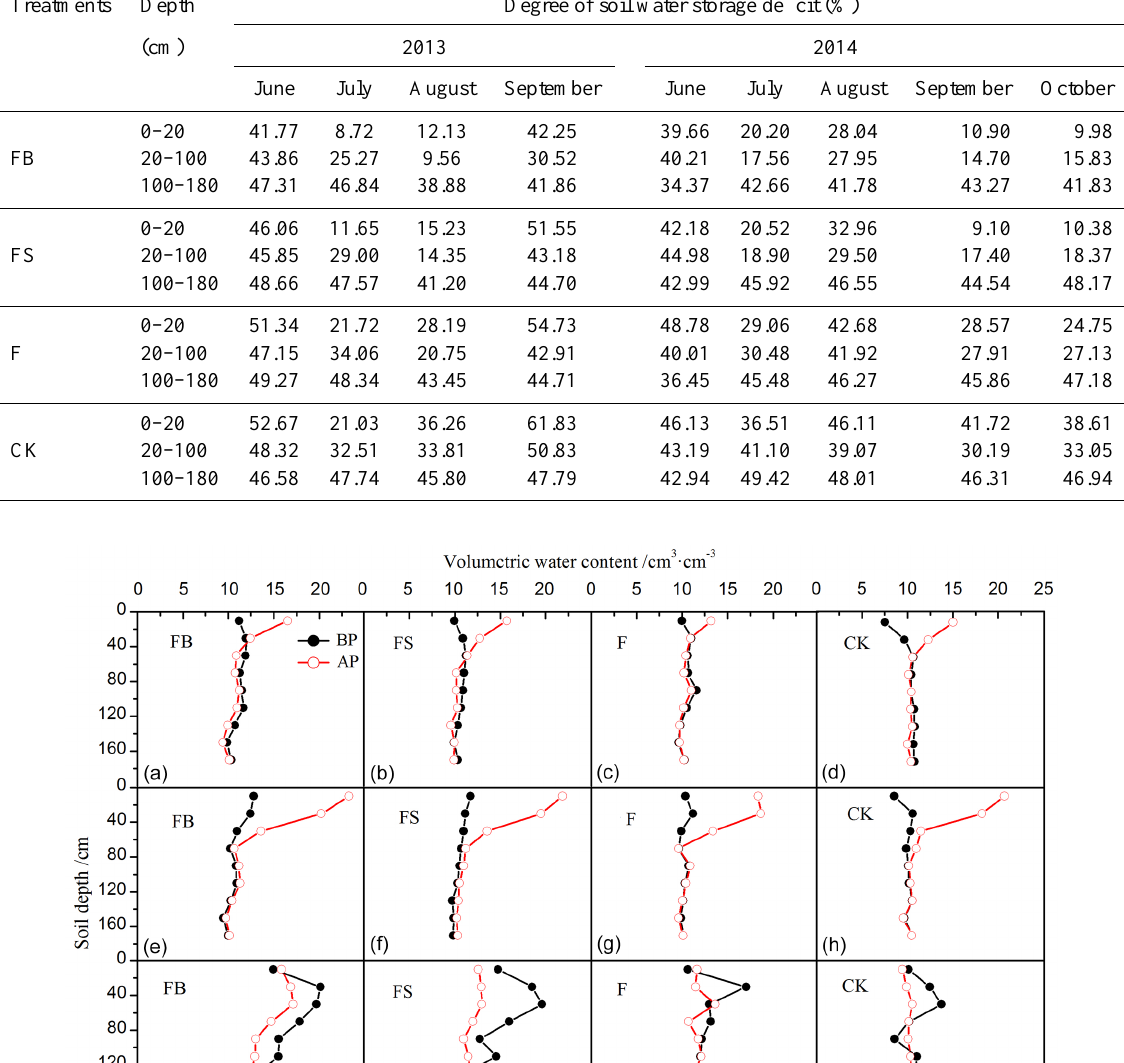
Table 2. Deficit degree of soil water storage under fish-scale pits with branch mulching (FB), fish-scale pits with straw mulching (FS), fish-scale pits without mulching (F), and bare land treatment (CK).